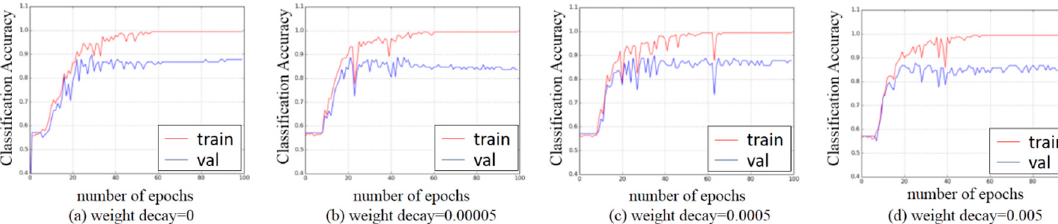
Figure 11. Comparison of classifier performance of different weight decays. ( a ) weight decay = 0; ( b ) weight decay = 0.00005; ( c ) weight decay = 0.0005; ( d ) weight decay = 0.005. Table 4. Hyper-parameters obtained.